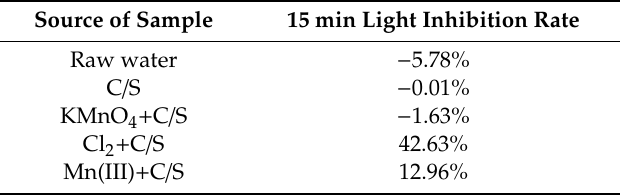
Table 2. Light inhibition rate before and after